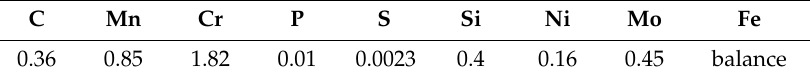
Table 1. Nominal chemical composition of the investigated steel ingots, wt.%. C Mn Cr P